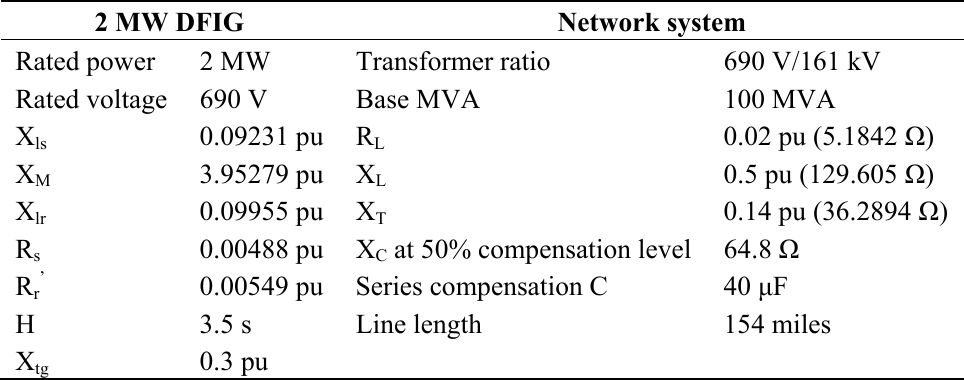
Table A1. Parameters of a single 2 MW DFIG and the network system.